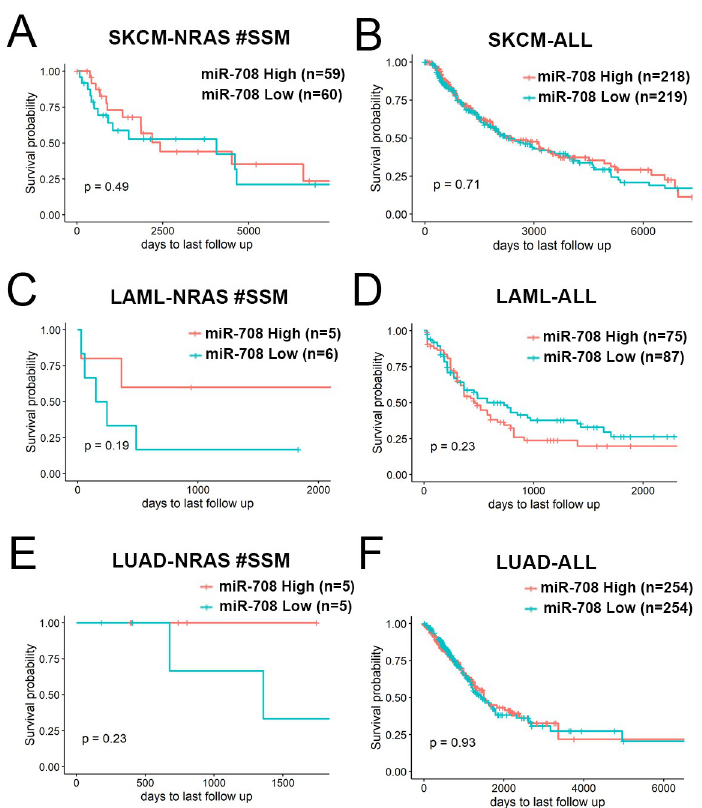
Fig 5. MicroRNA-708 showed moderate survival benefits in NRAS-mutated cancer patients. Retrospective analysis of Kaplan-Meier plots for miR-708 expression in association with overall survival. (A) 119 patients with Skin Cutaneous Melanoma (SKCM) carrying NRAS simple somatic mutation (#SSM). (B) 437 patients in all SKCM. (C) 11 patients from Acute Myeloid Leukemia (LAML) with NRAS #SSM. (D) 162 patients in all LAML. (E) 10 patients from Lung Adenocarcinoma with NRAS #SSM. (F) 508 patients in all LUAD. Patients were split into high and low expression groups based on the median expression of the miR-708. The log-rank test was used for the statistical